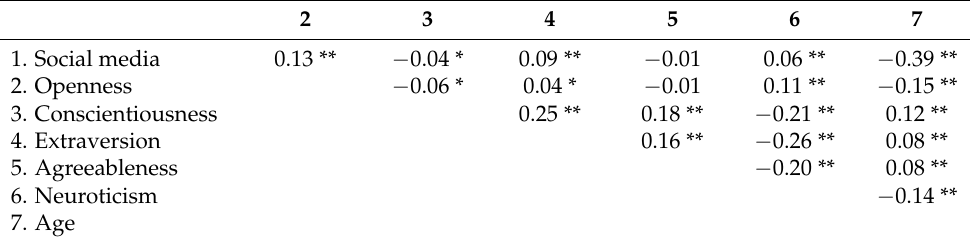
Table 5. Intercorrelations of study variables 2: social media usage, Big Five (BFI-10),